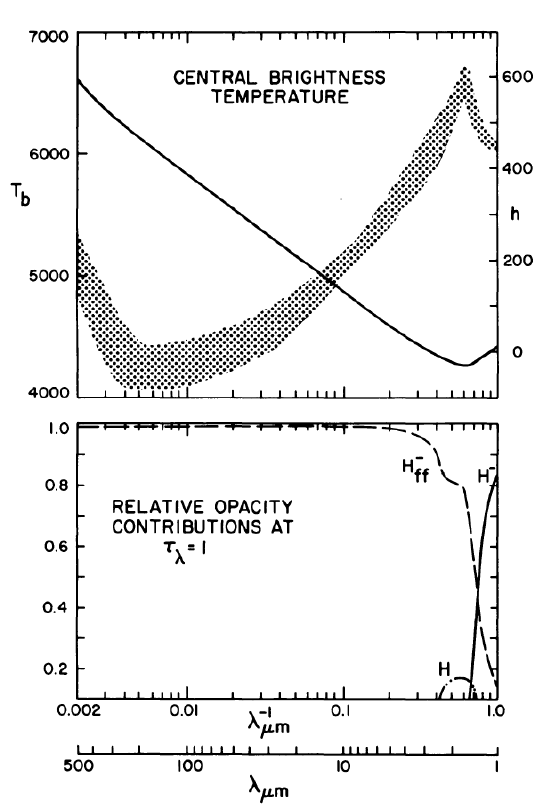
Figure 5: The height of formation of the infrared continuum radiation is shown in this figure. The continuum radiation is formed at the deepest level in the Sun at 1600 nm, and then the continuum formation height increases with increasing wavelength in the infrared spectrum. The bottom plot shows that the dominant source of opacity is from Hydrogen free-free transitions. See also Fontenla et al. (2006) for more recent work. Image reproduced with permission from Vernazza et al. (1976), copyright by AAS.